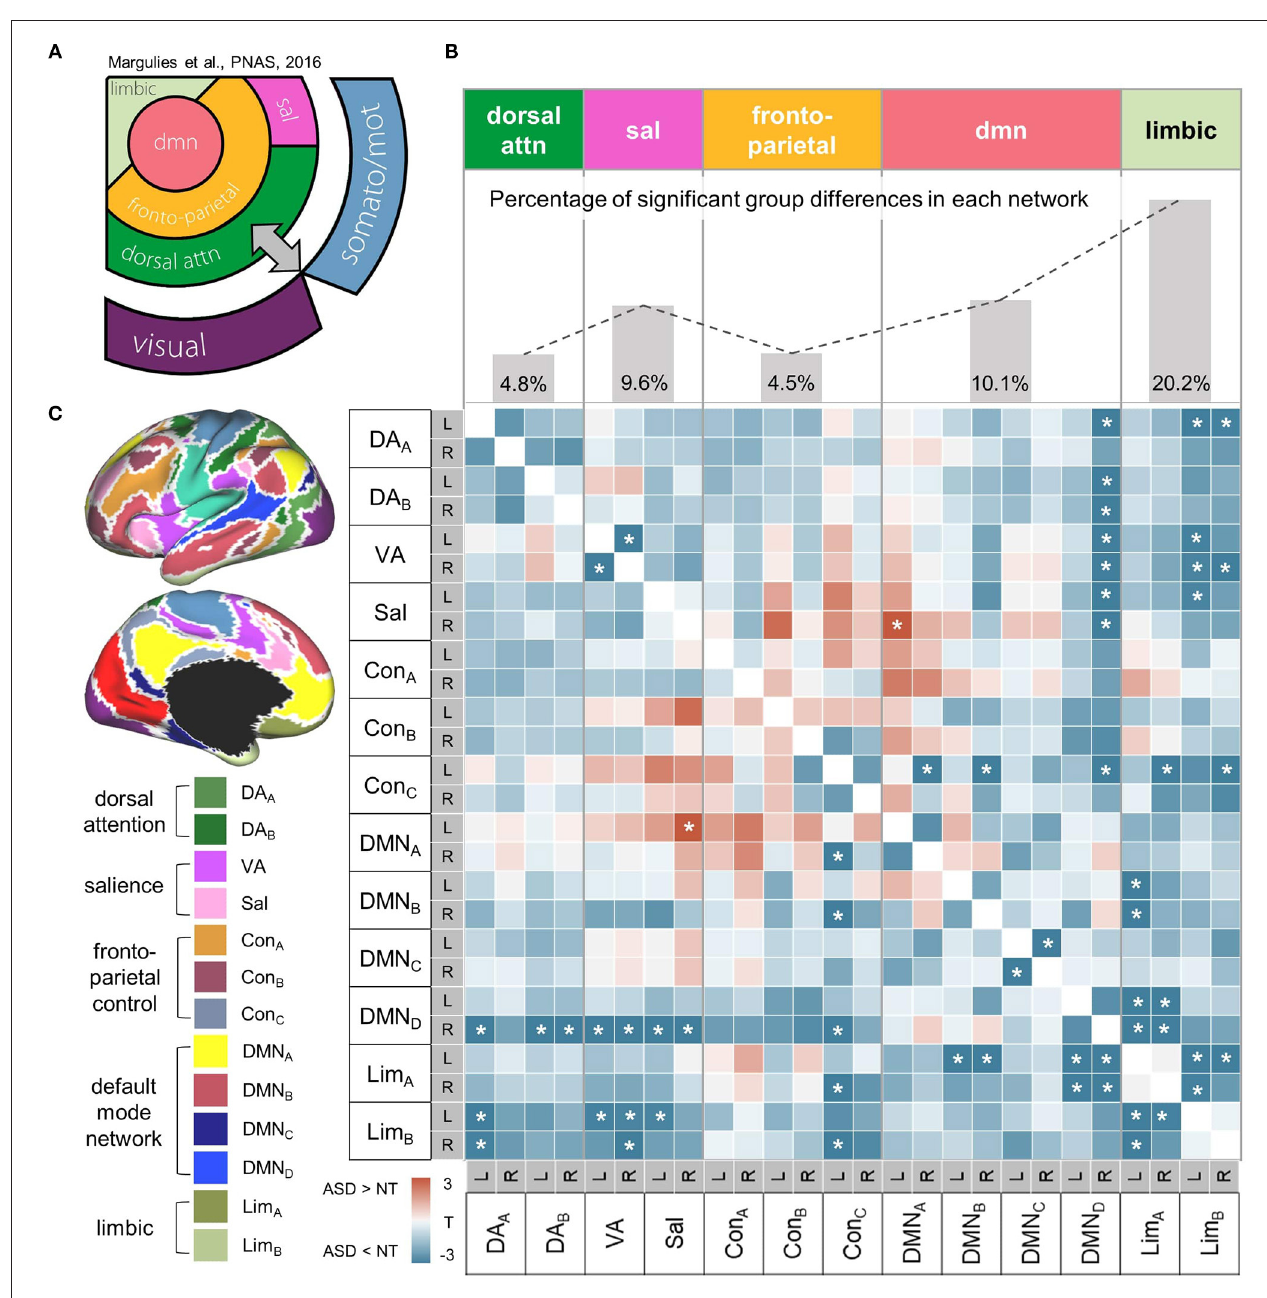
FIGURE 3 | Within-high-order transmodal network. (A) A schematic diagram showing the hierarchical relationships of canonical resting-state networks. The figure component adapted from Margulies et al. (55). (B) Top. The proportion of altered connectivity in ASD shows an increasing trend along the hierarchy of high-order networks that was aligned based on the schematic diagram on the left. Bottom. A heatmap representing correlation coefficients of intrinsic functional connectivity (iFC) within high-order networks. Markedly decreased iFC in ASD suggests a less integrated high-order transmodal system. Significant group differences in iFC between ASD and NT are shown with asterisks (FDR = 0.05). (C) High-order network parcels were derived from the Yeo-Krienen 17 resting state networks (68). DA, dorsal attention network; VA, ventral attention network; Sal, salience network, Con, frontoparietal control network; DMN, default mode network; Lim, limbic network.